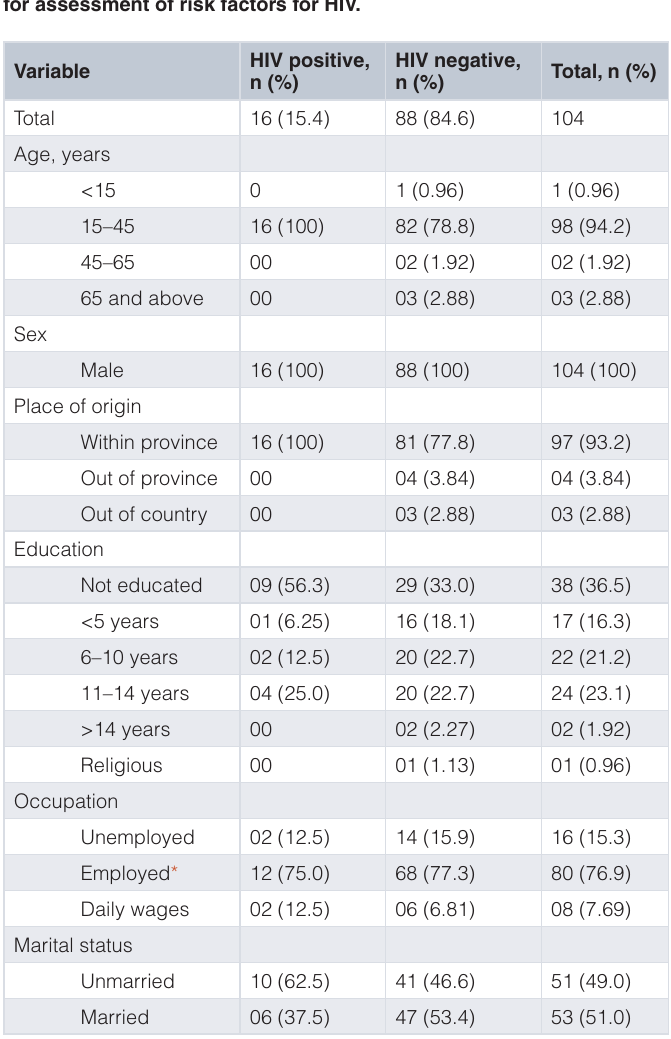
Table 1. Sociodemographic characteristics of prisoners interviewed for assessment of risk factors for